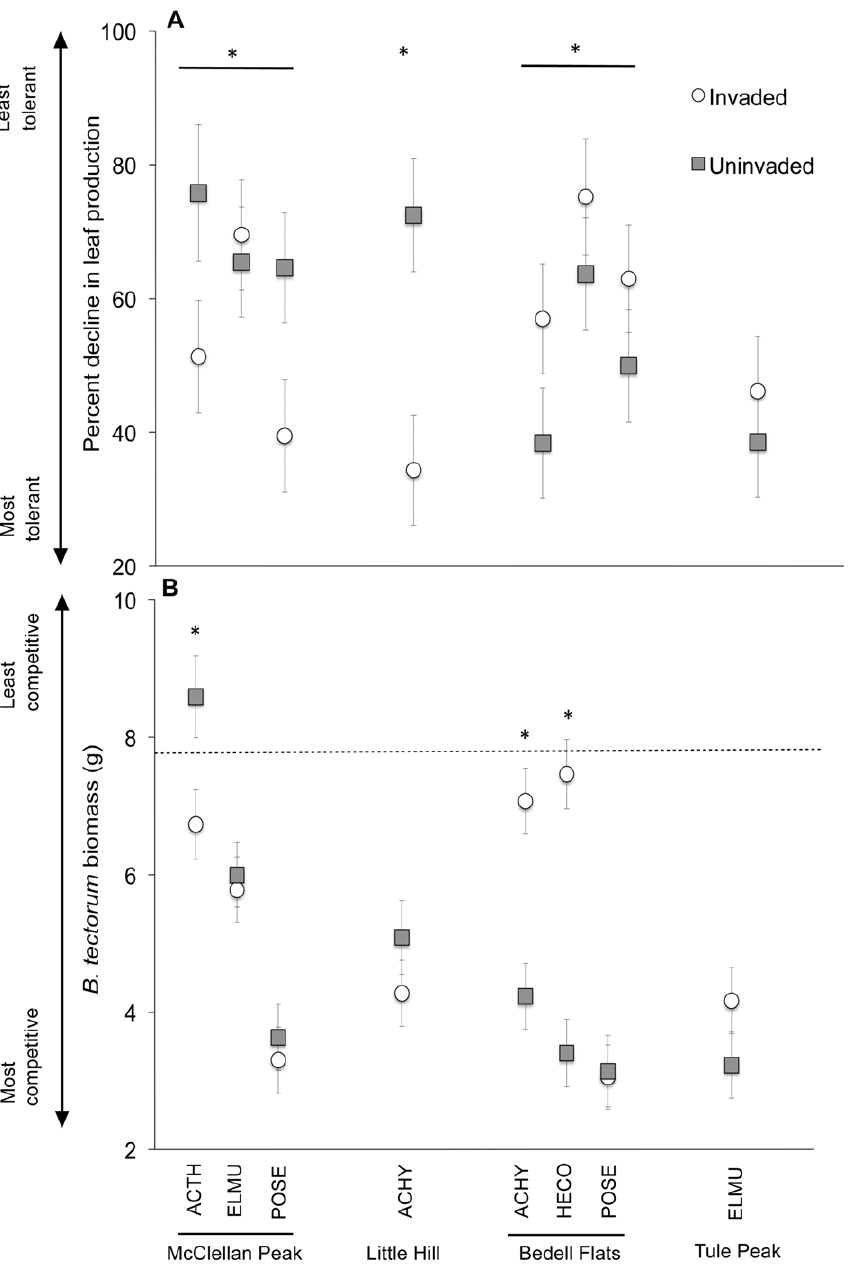
Figure 4. Tolerance and competitive effect of five native perennial grasses from invaded and uninvaded populations. Mean percent decline in biomass of target species from B. tectorum invaded and uninvaded communities at Bedell Flats, Little Hill, McClellan Peak, and Tule Peak when grown in competition with B. tectorum (a) and biomass of B. tectorum when grown with target species (b). Dotted line indicates B. tectorum biomass when grown in monoculture (not included in analysis but plotted for comparison). Asterisks indicate significant differences between invaded and uninvaded communities ( P , 0.05) based on post-hoc contrasts.